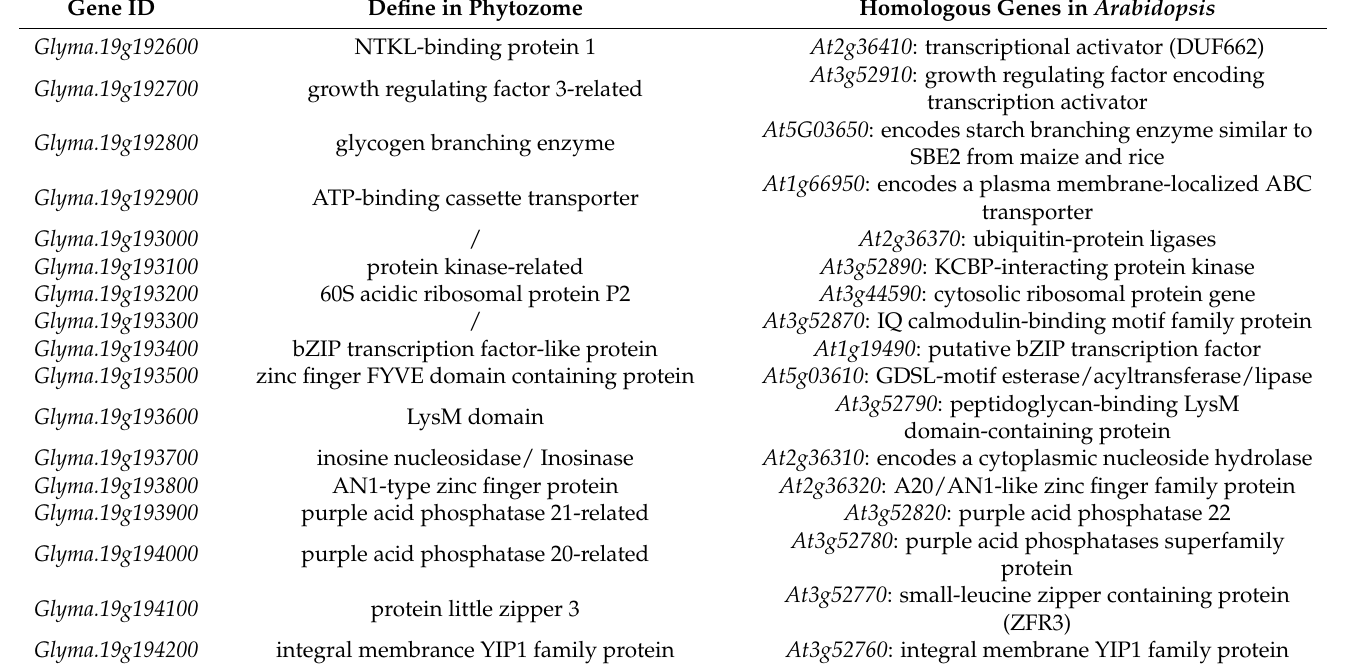
Table 4. Genes located within 130 kb upstream and downstream of significant SNPs AX-93897192 and